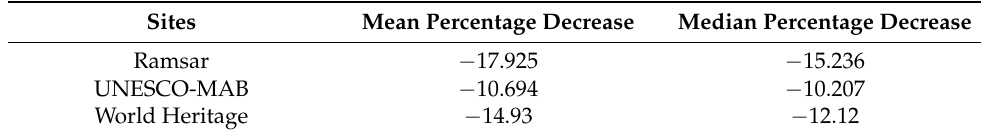
Table A2. The decrease in mean and median (light intensity) for PAs with international designations.